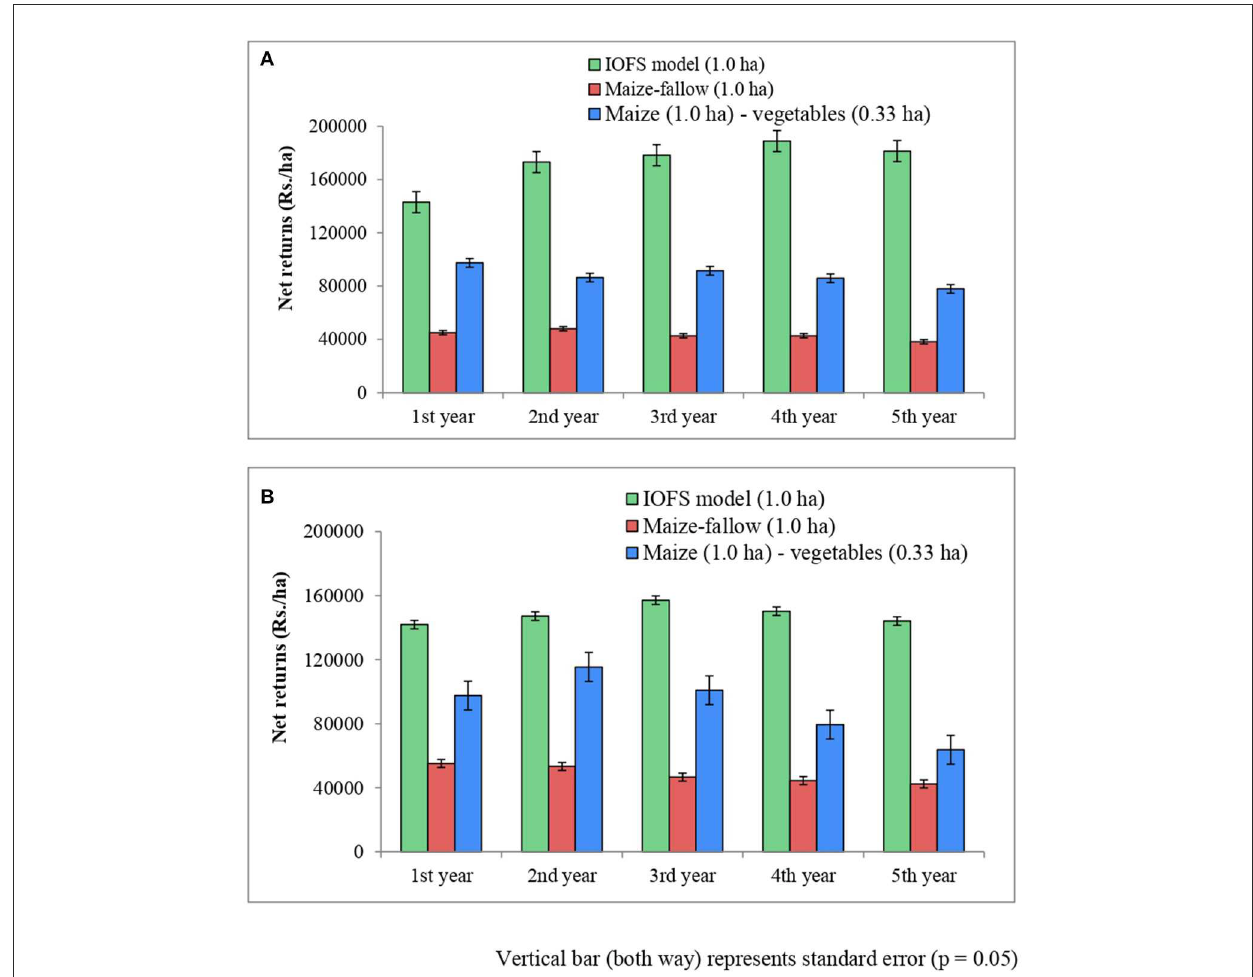
FIGURE5 Net return/ha over 5 years from the IOFS models of Mr. Jrill Makroh (A) and Mrs. Skola Kurbah (B) compared with common farming